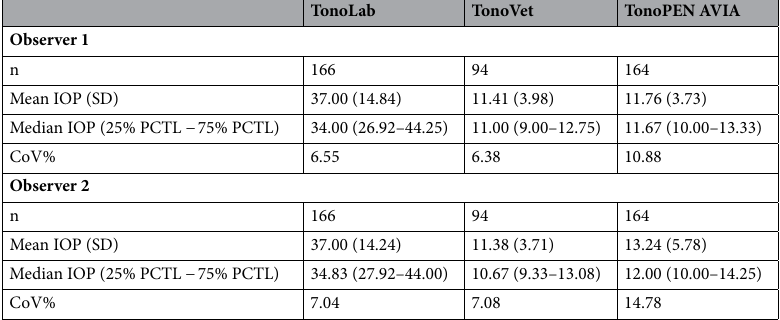
Table 2. Summary of IOP results of both observers. Measurements performed in triplicate, IOP expressed in mmHg. Coefficient of variation (CoV), standard deviation (SD), percentile